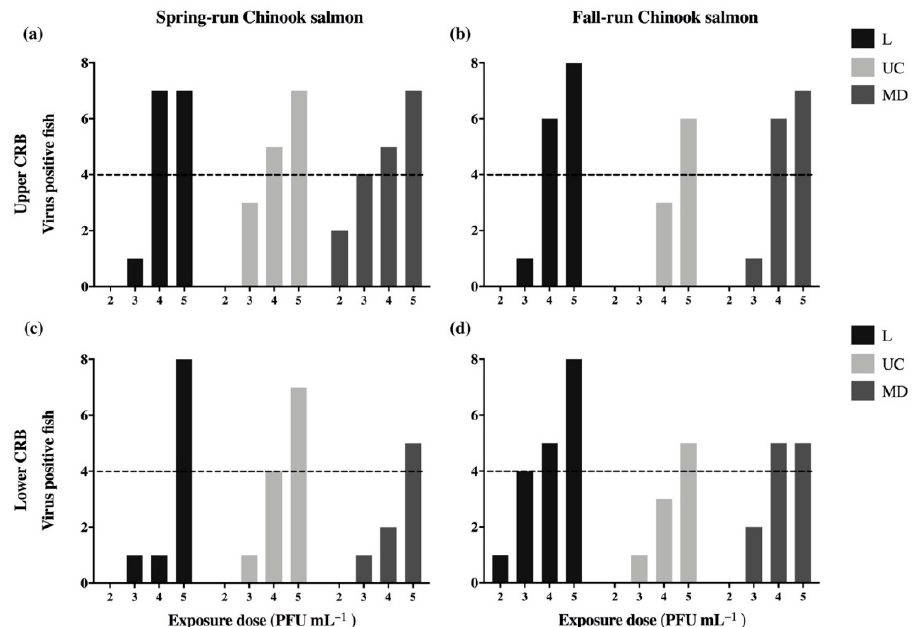
Figure 3. Virus positive spring-( a , c ) and fall-run ( b , d ) Chinook salmon of the upper ( a , b ) and lower ( c , d ) Columbia River Basin at 3 days post exposure to L, UC, and MD strains of IHNV by static immersion. Exposure dosages of 2 × 10 2 PFU mL − 1 through 2 × 10 5 PFU mL − 1 are reported along x -axes as exponents of viral challenge concentrations. The y -axis indicates the number of virus positive fish out of a total of 8 fish per treatment group, and dotted lines indicate 50% infection.